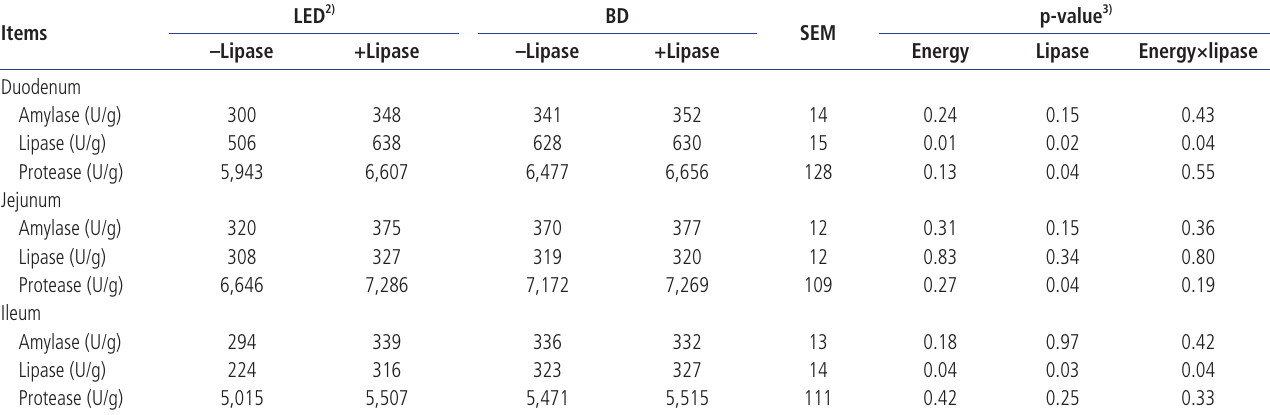
Table 5. Effects of dietary energy and lipase levels on small intestinal digestive enzyme activities in weaning pigs